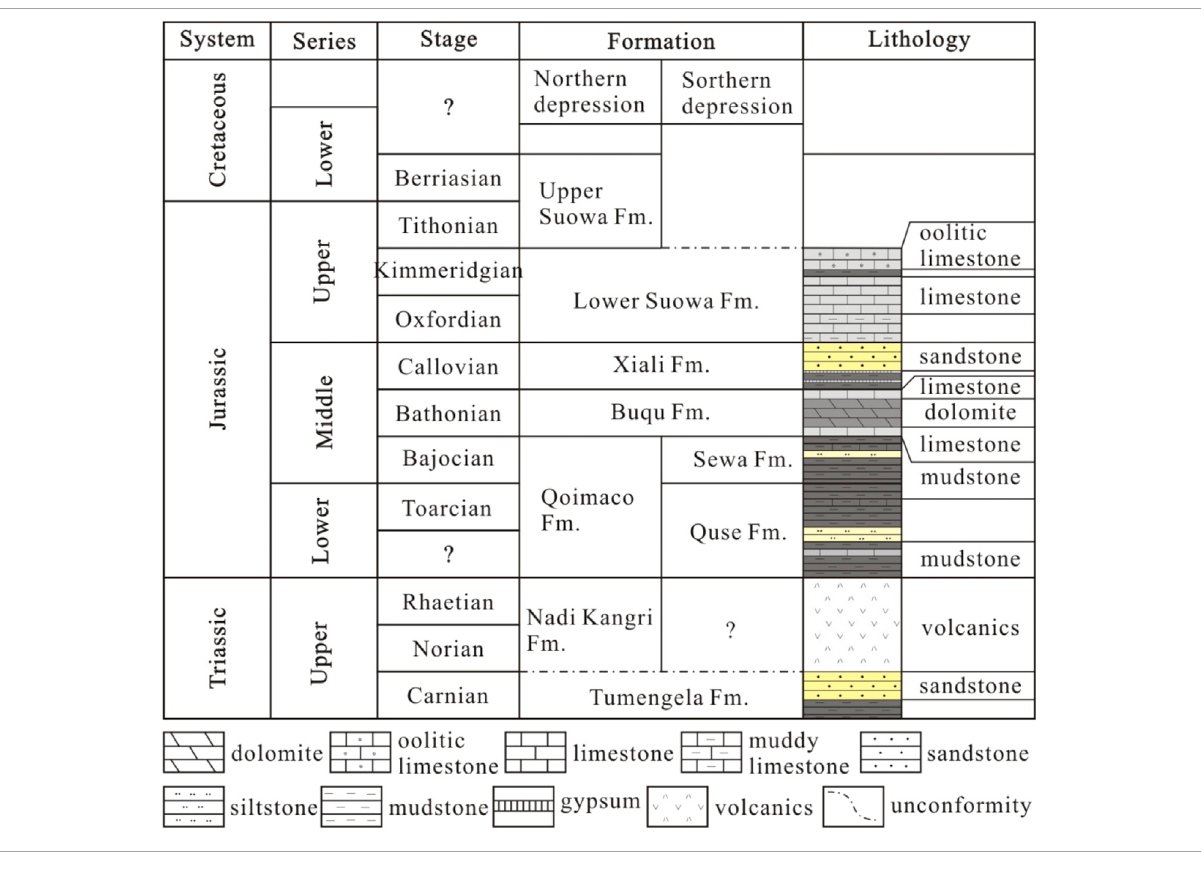
TABLE 1 Generalized stratigraphic column of the Qiangtang